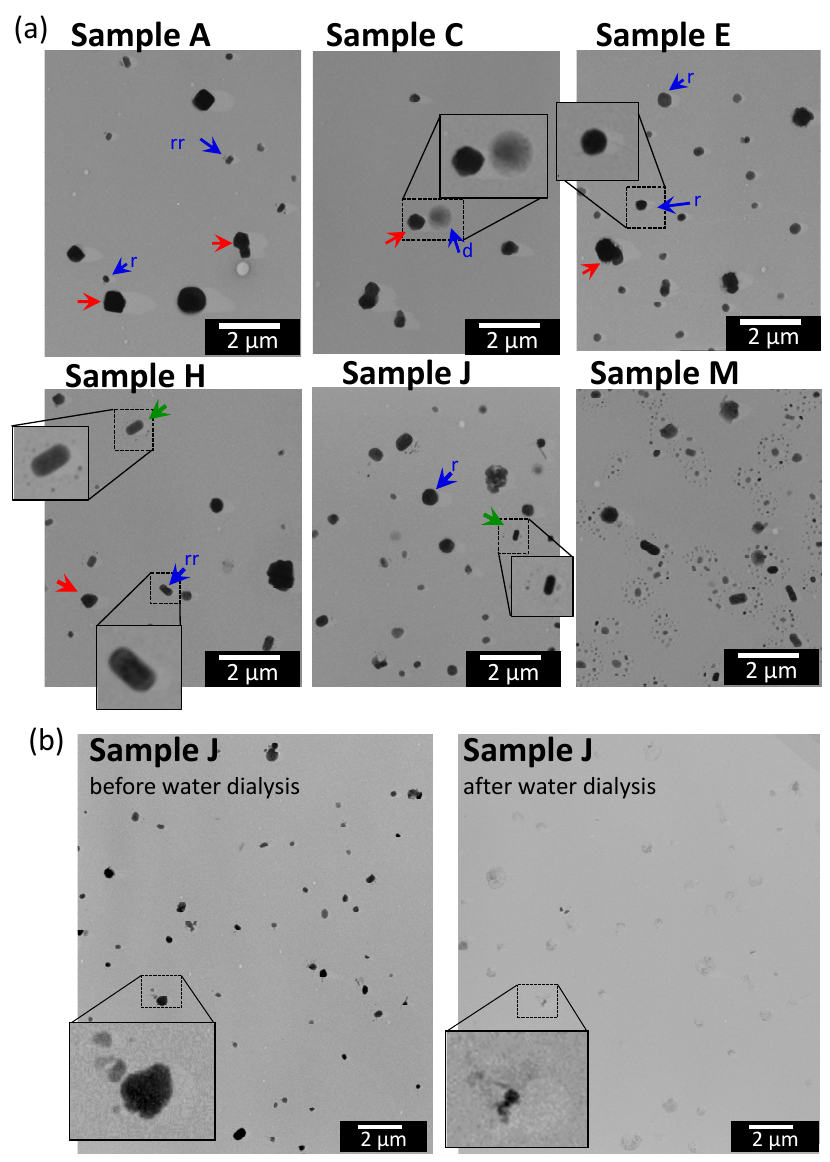
Figure 9. Electron micrographs for (a) samples A, C, E, H, J, and M, and (b) before and after dialysis of sample J for the same sample region. Magnifications of all microphotographs of (a) are the same. Red arrows indicate examples of particles with a sea-salt shape. Blue arrows indicate examples of particles with a sulfate particle shape (d, dome-like, r, round, and rr, rotundate rectangular particles). Particles with a satellite structure in samples H and J are marked by green arrows. See main